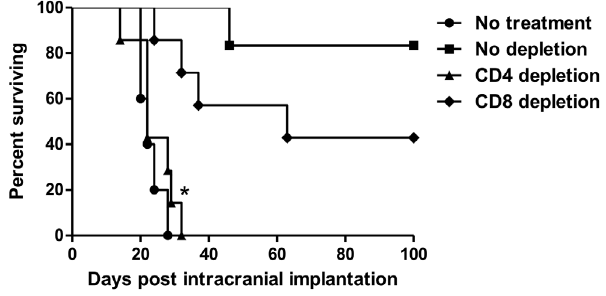
Figure 5. The anti-tumor activity of triple therapy is CD4 + T cell dependent. Kaplan Meier survival curves for untreated animals, triple therapy (no depletion), triple therapy with depleted CD4 + T cells and triple therapy with depleted CD8 + T cells ( n =5–7 mice/group). CD4 + T cell depletion abolishes the survival benefit of triple therapy ( p , 0.001). Depletion of CD8 + T cells did not interfere with the efficacy of triple therapy and resulted in long-term survival.